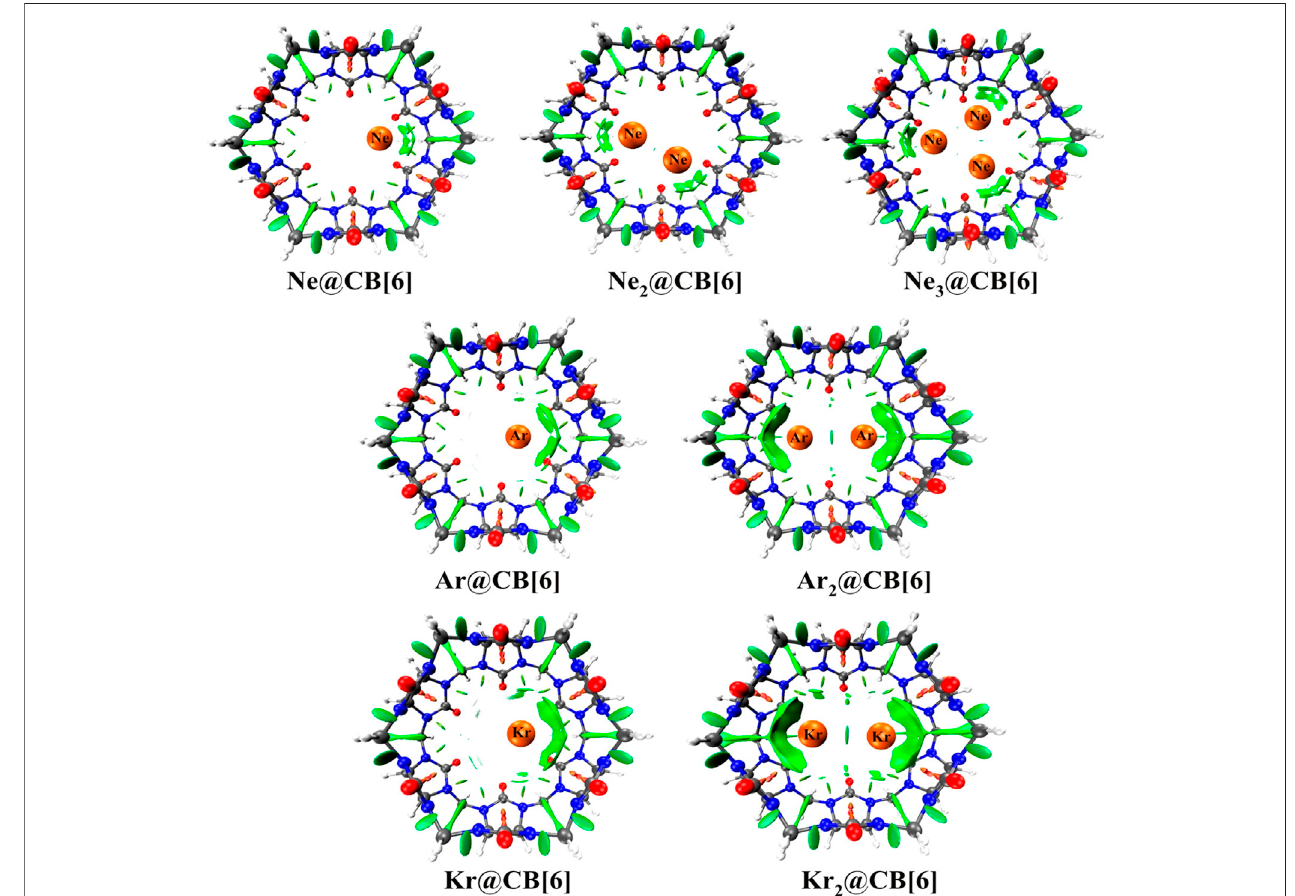
FIGURE 9 | NCI plots of Ng n @CB[6] complexes. (Reprinted with permission from Pan et al., 2015. Copyright© 2015, American Chemical Society.).